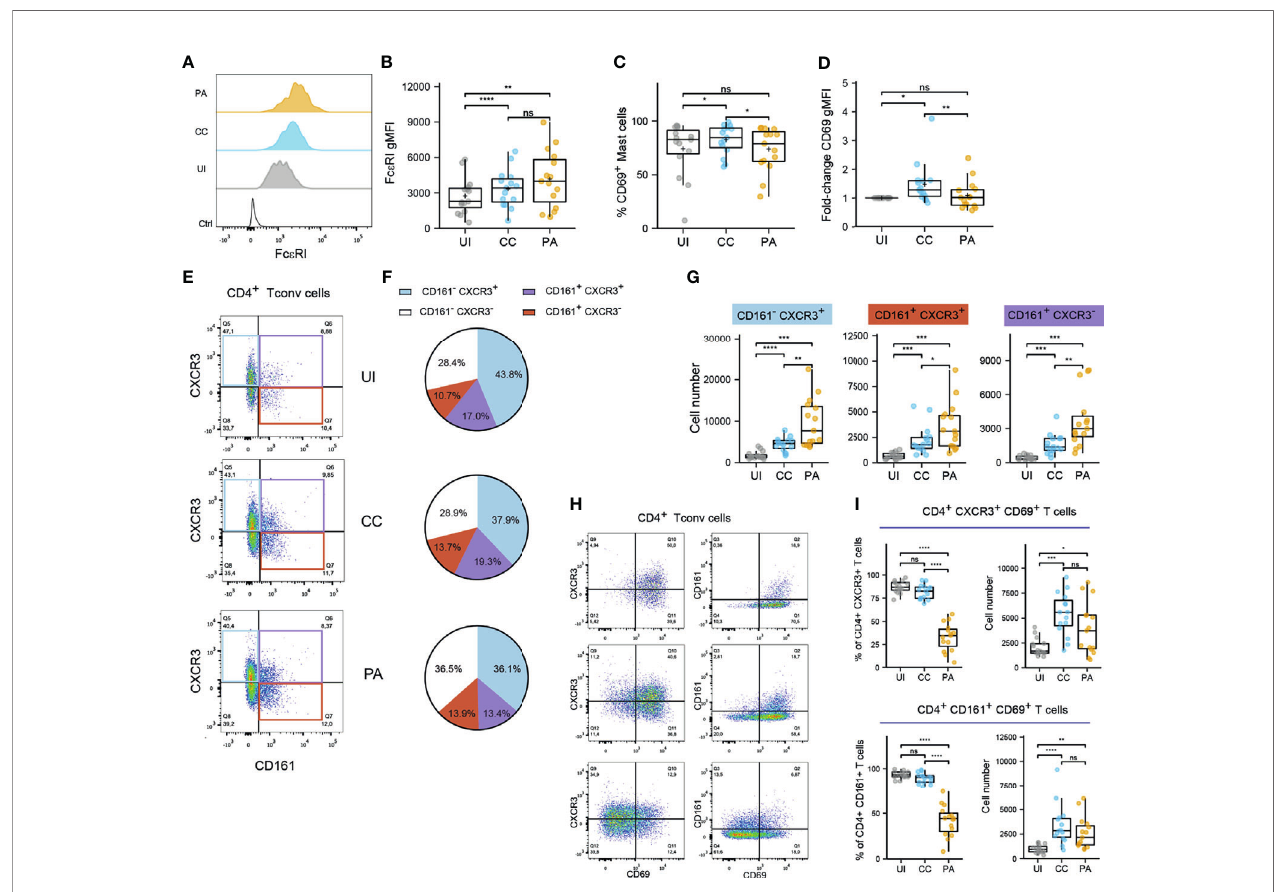
FIGURE 2 | Mast cells and CD4 + T cells exhibit activated in the early stages of acne. (A, B) Fc e RI expression by mast cells. Typical histograms (B) and pooled data as Fc e RI gMFI values from the 15 patients. (C, D) CD69 expression by mast cells. % CD69 + mast cell (C) and CD69 gMFI fold-change over UI skin (D) . Points represent the individual values for the 15 patients. Box and whiskers plots in the style of Tukey. *p < 0.05; **p < 0.01; ns, not signi fi cant (one-way ANOVA and Fisher ’ s least signi fi cant difference post hoc test). (E) Representative dotplot of CD161 and CXCR3 expression within CD4 + Tconv cells (CC stage) and (F) average percentages of CD161/CXCR3 populations within CD4 + Tconv cells (15 patients). (G) Number of indicated CD161/CXCR3 CD4 + Tconv cell populations. (H) Representative dotplot of CD69, CD161 and CXCR3 expression within CD4 + Tconv cells (CC stage). (I) Percentage and number of CD69 + cells among CXCR3 + or CD161 + CD4 + Tconv cells. Box and whiskers plot in the style of Tukey. Each point represents a patient. Friedman tests were carried out to compare groups and, if signi fi cant, were followed by Dunn ’ s post hoc tests *p < 0.05; **p < 0.01; ***p < 0.001; ****p < 0.0001; ns, not signi fi